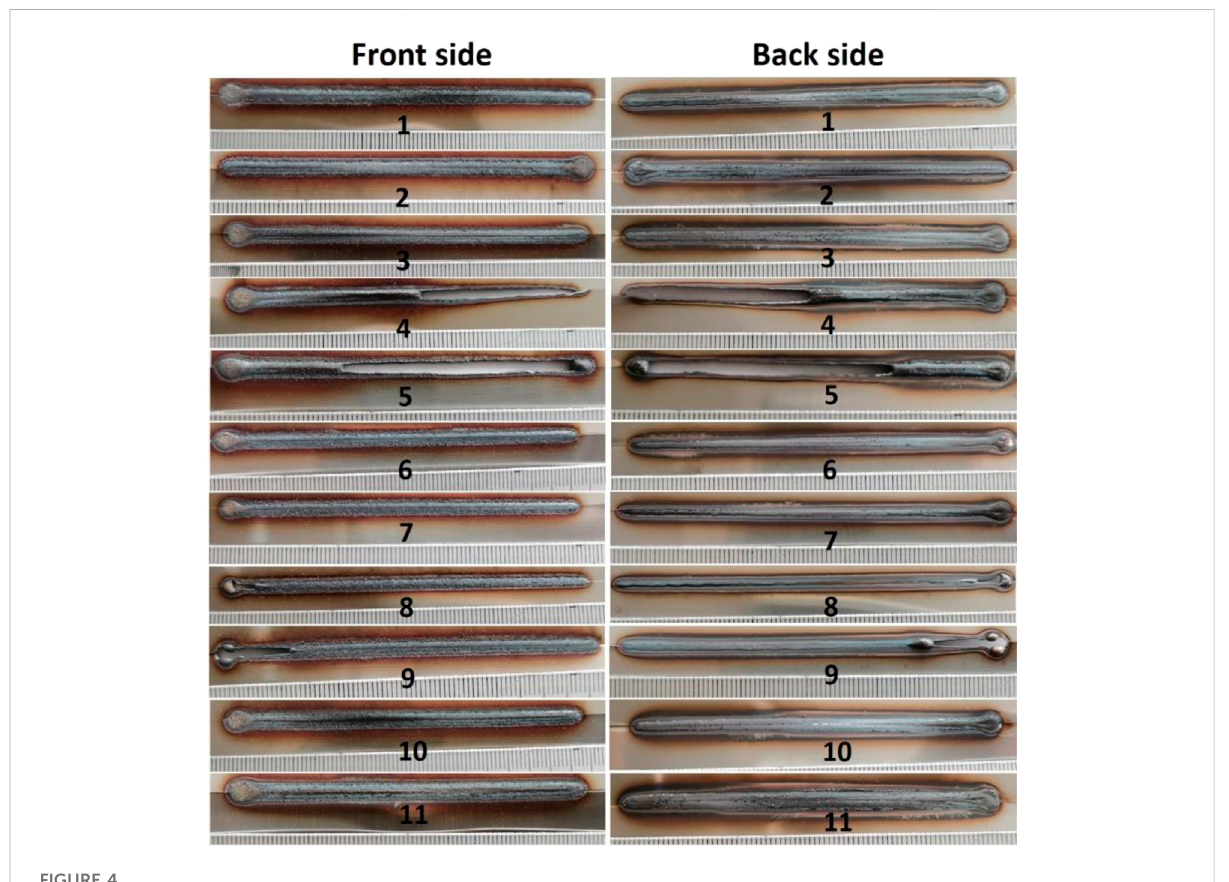
FIGURE 4 Optical microstructure of the cross section of sample